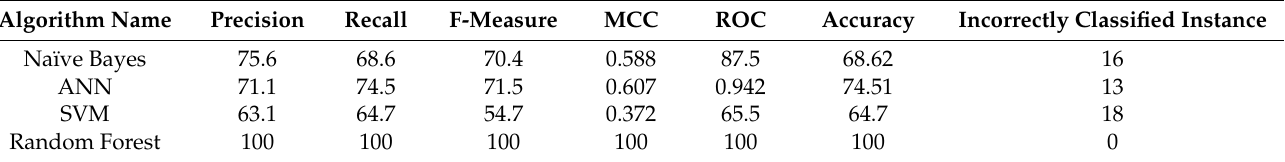
Table 4. Comparison among classification algorithms during the training phase to predict the total